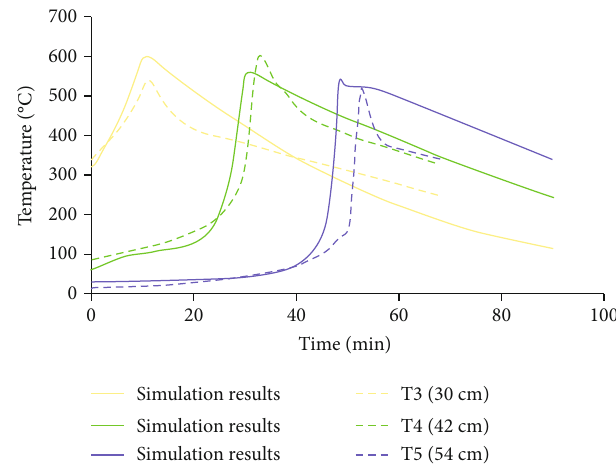
Figure 14: The temperature evolution at the locations of temperature measurement points along the tube (T3 ~ T5) in D block combustion tube numerical